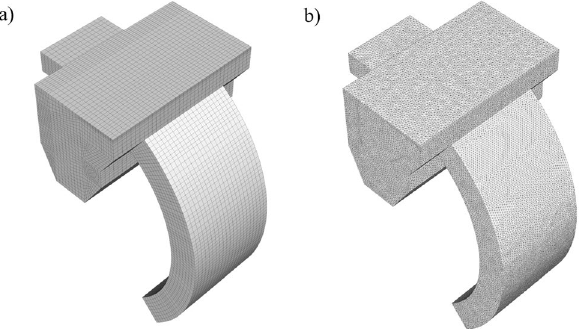
Figure 3. Grid diagram of the recovery unit: ( a ) structural grid; ( b ) non-structural grid.